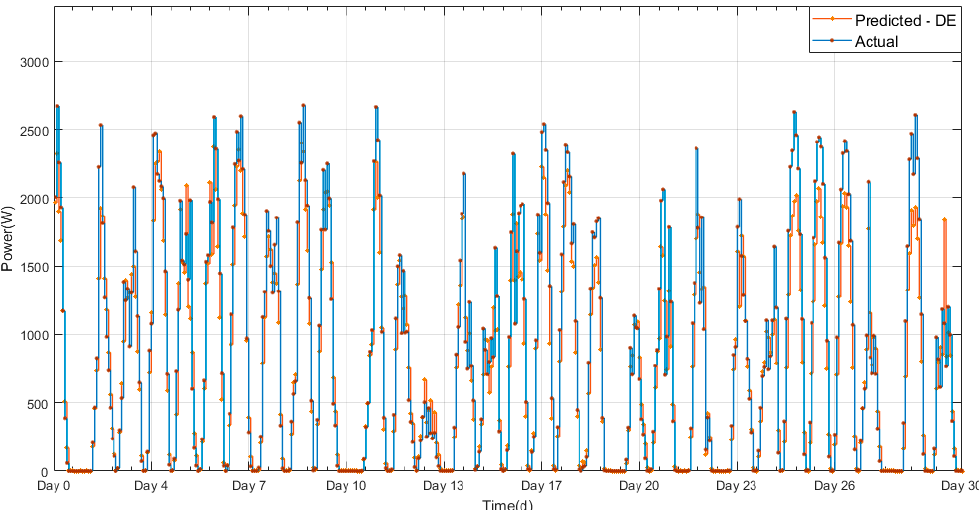
Figure 16. DE-forecasted and actual values of PV output power.